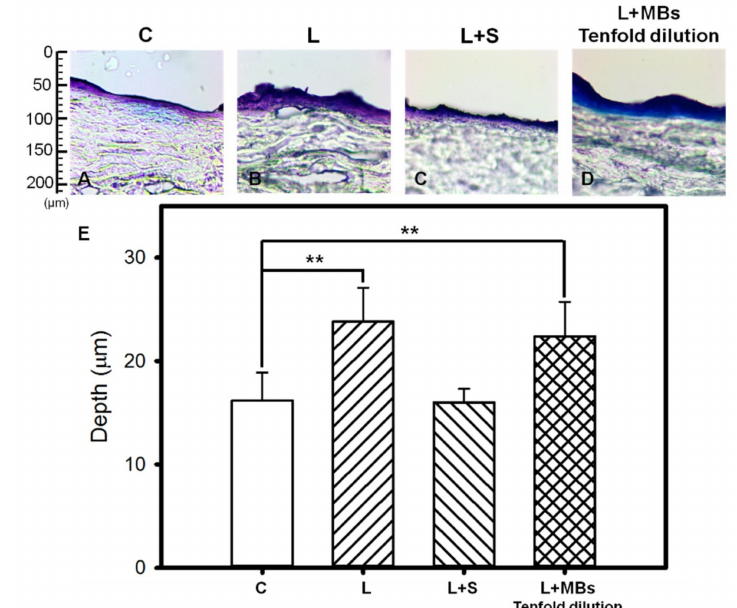
Figure 6. Light-microscope evaluation of pigskin samples in group C ( A ); for irradiation by the CO 2 fractional pulsed laser directly (group L) ( B ); and for laser irradiation combined with saline (group L + S) ( C ) and tenfold-diluted MBs (group L + MBs) ( D ); ( E ) Quantification of the penetration depths of Evans blue in panels ( A – D ) (** p < 0.01). Data are mean and SD